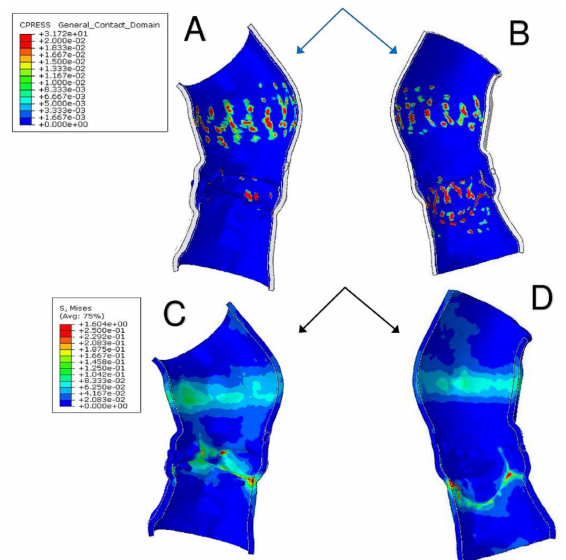
Figure 7. ( A , B ) Stent-root interaction area shows regions of aortic root elements with a contact pressure higher than zero. Quantitative measure of the device footprint onto the inner wall of the aortic root after expansion is shown. The evaluation of stent adhesion and anchoring to the aortic wall allows to reveal areas with inadequate stress and contact potentially leading to device migration. ( C , D ) Von Mises average stress measures the forces induced by the device expansion onto the inner wall of the aortic root and the quantitative and qualitative evaluation of their locations with higher peak stress. Higher values of stress also mean higher global anchoring force.